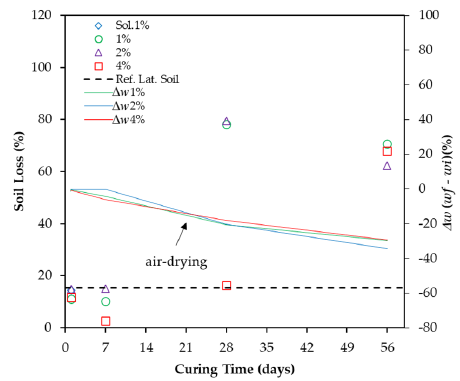
Figure 8. Percentage of soil mass loss based on curing time. Lateritic soil reference (Ref. Lat. Soil) = untreated soil; ∆ w = water content variation; Sol.1% = 1% of lime saturated solution.